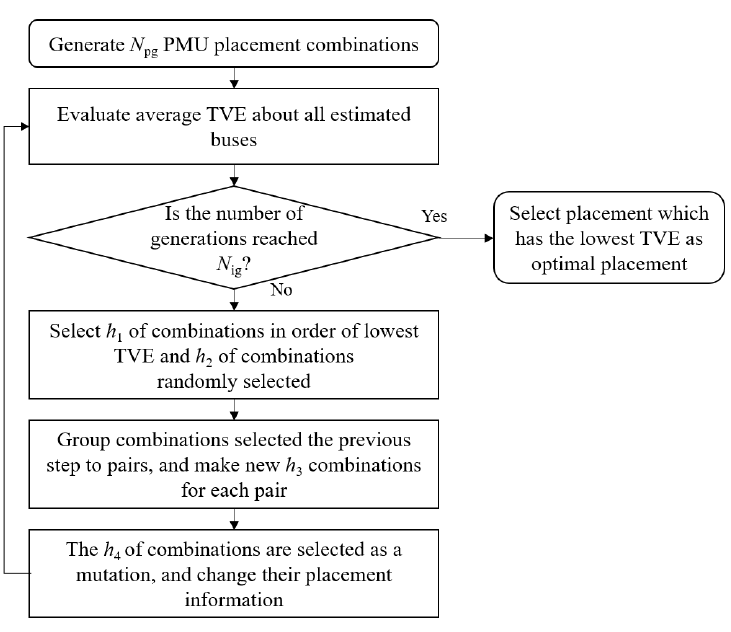
Figure 2. Flowchart of GA.